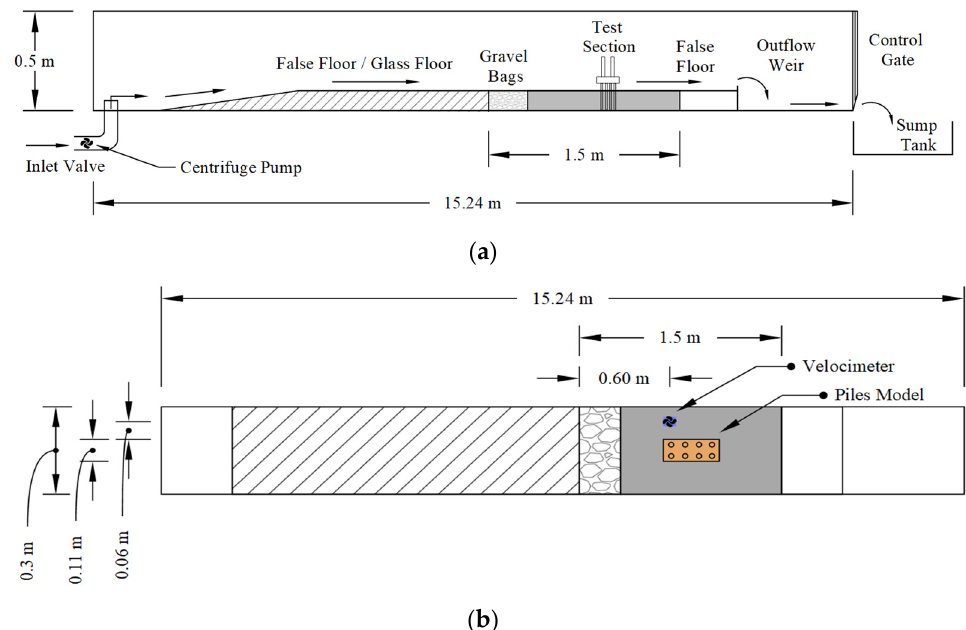
Figure 1. ( a ) The schematic side view drawing of the flume used in the present study. ( b ) The schematic plan view drawing of the flume used in the present study.